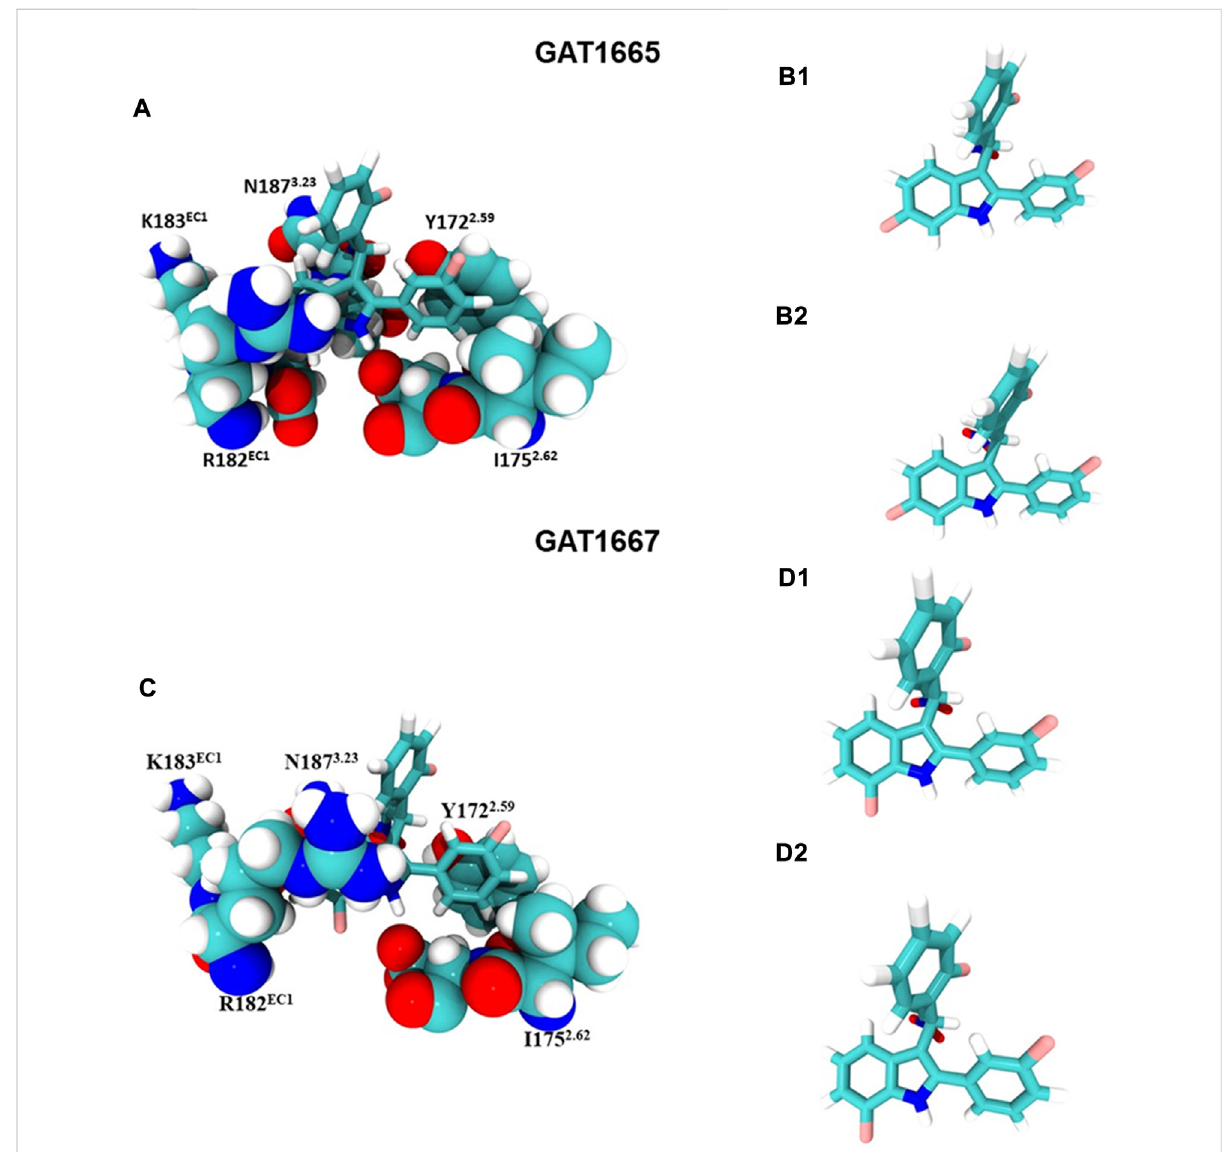
FIGURE 8 GAT1665 and GAT1667 bind to a putative PAM site. ( A ) GAT1665 main interactions and the amino acid residues of the binding pocket displayed in pink in Figure 6. The conformation of GAT1665 before it binds to hCB1R (B1) and then the conformation of GAT1665 after it binds to hCB1R (B2) . (C) GAT1667 main interactionsand theamino acid residues ofthebindingpocket displayed inpink inFigure 6. The conformationof GAT1667 before it binds to hCB1R (D1) and then the conformation of GAT1667 after it binds to hCB1R (D2)